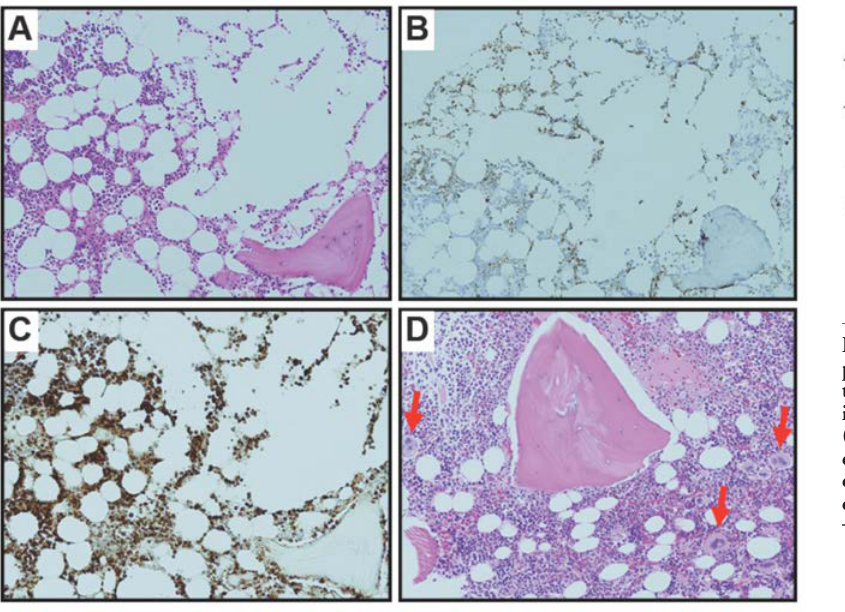
Figure 2. Histopathological images of the bone marrow. A) Bone marrow biopsy section, obtained on Day 3 after hospital admission, showing hypoplasia and scant megakary- ocytes (hematoxylin and eosin stain). B) Glycophorin A staining revealed decreased ery- throid numbers. C) Myeloperoxidase staining revealed adequate numbers of myeloid cells. D) Repeat bone marrow biopsy section obtained on Day 226 revealed that the hypoplasia had resolved, and many megakaryocytes can be seen (arrow) (hematoxylin and eosin stain).